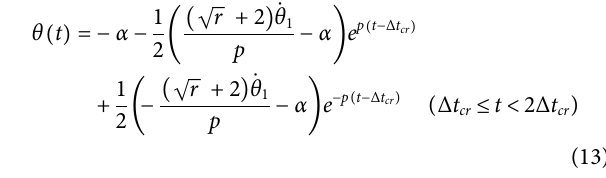
Frontiers in Built Environment |